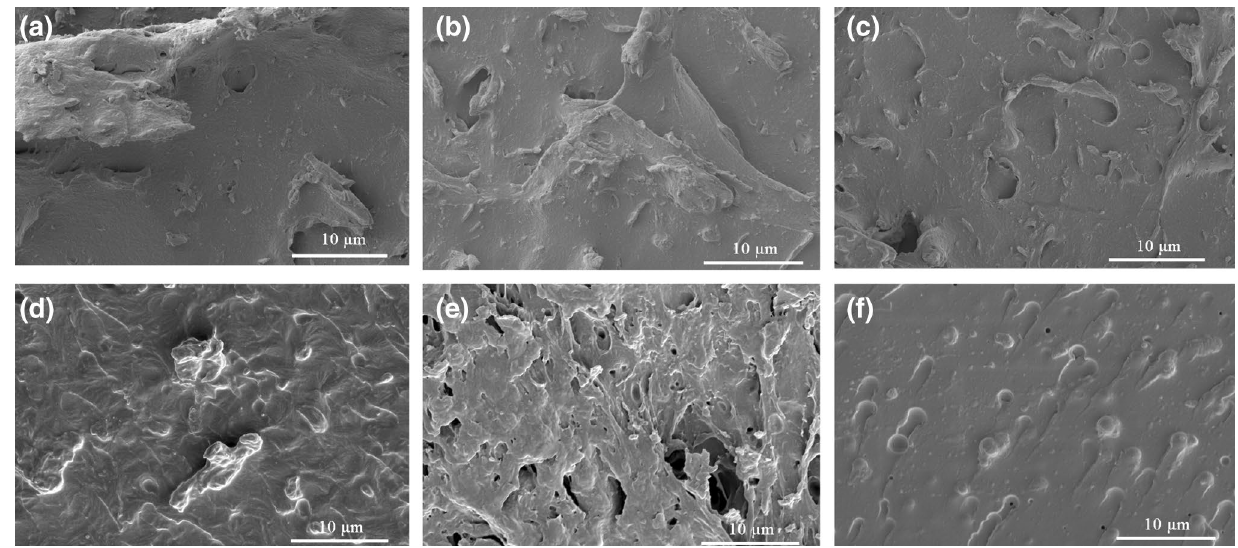
Fig. 7 SEM images of PU/PVDC composite films containing different types and concentrations of cellulose nanocrystals; a 0.05% CNC 0.1% CNC w , c 0.3% CNC w , d 0.05% CNC m , e 0.1% CNC m and f 0.3% CNC